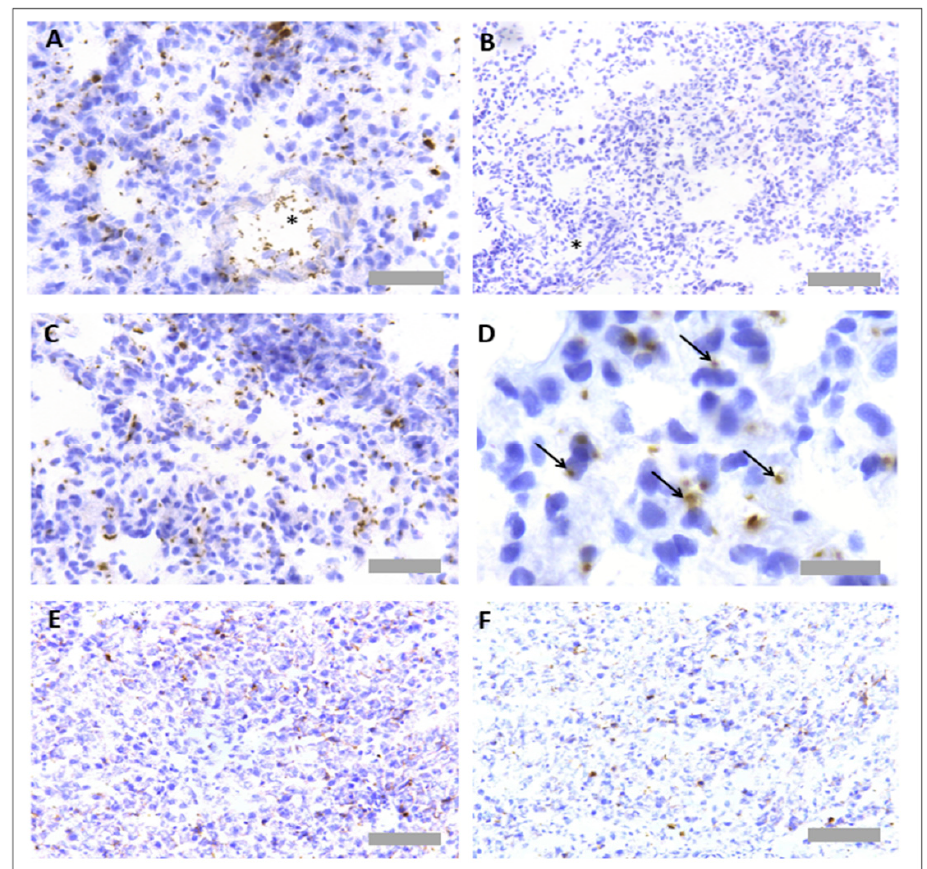
Figure 3. Platelet immunohistochemistry in rat lung and liver tissues. For protocol optimisation, sections were immunostained with primary antibody ( A ) and without primary antibody ( B ), to ensure no unspecific binding of detection reagents. Representative images of platelet immunohistochemistry (anti-CD61) in frozen rat lung tissue ( C , D ) and frozen rat liver tissue ( E , F ) are also shown. Asterisks denote blood vessels. Arrows denote CD61+ events. Scale bar = 50 µ m in ( A , C ) ( × 40 objective), 100 μ m in ( B , D , E , F ) (×20 objective).